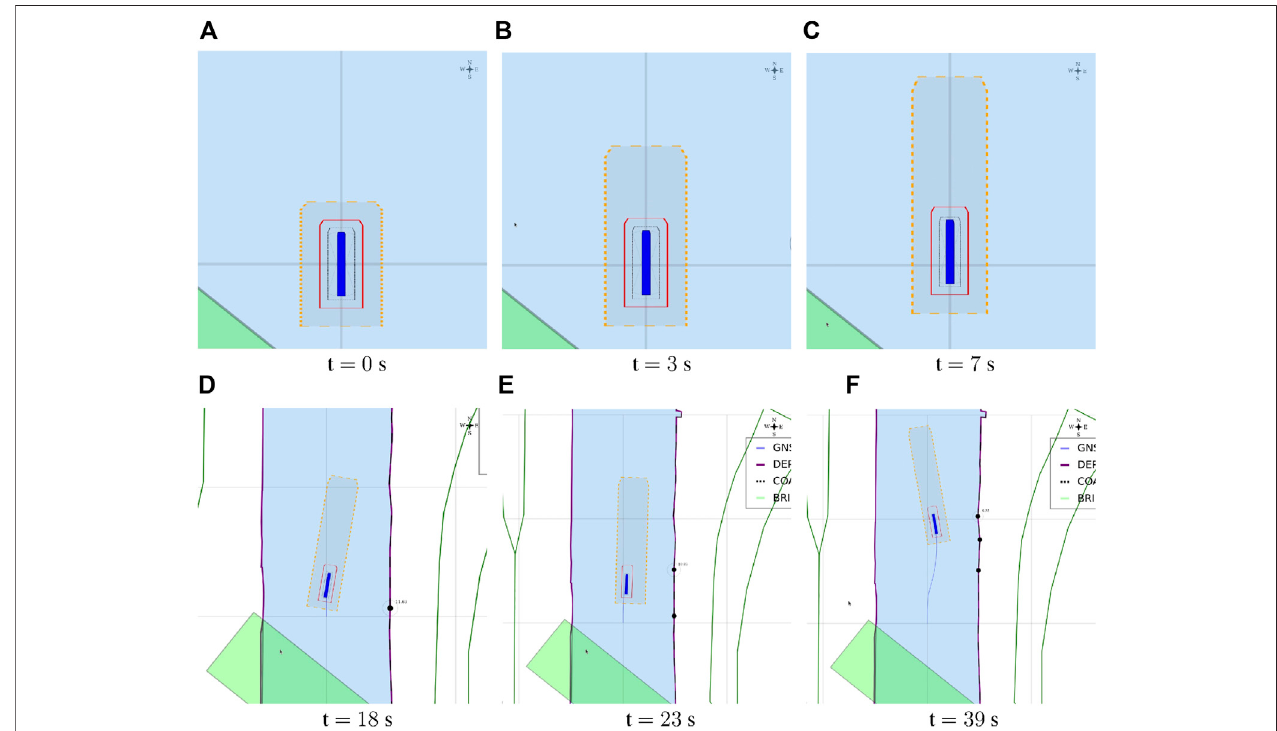
FIGURE 9 | Dynamic behaviour of SD1 and SD2 based on the hydrodynamic motion model of the vessel.